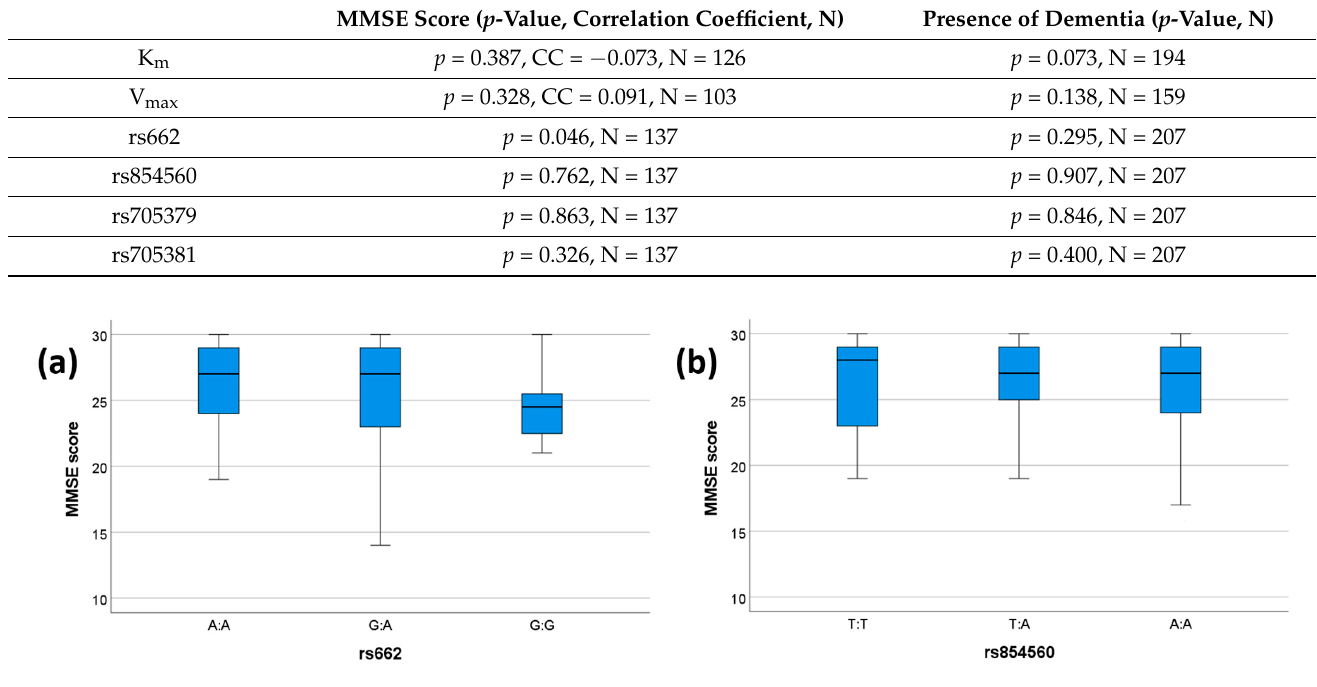
Table 7. The associations between PON1 genetic/enzyme-kinetic parameters (K m , V max , and geno- type) and cognitive parameters (MMSE and presence of dementia). Correlation coefficients are shown only for comparisons of numeric parameters.